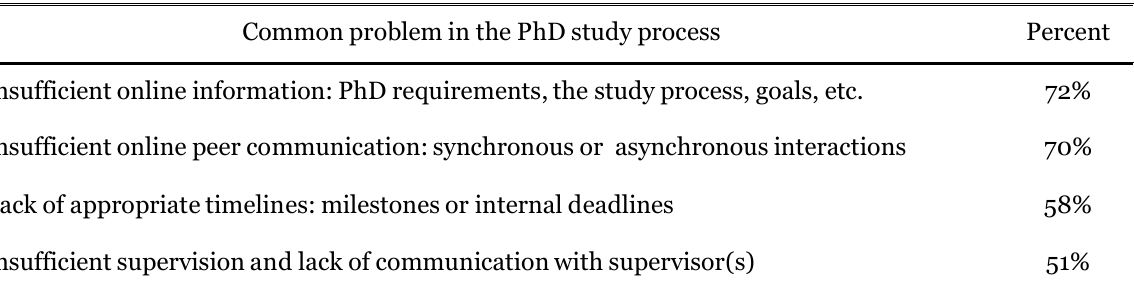
Sorted Problems Based on the Agreement of the PhD Students with the Following Issues Common problem in the PhD study process Insufficient online information: PhD requirements, the study process, goals, etc.